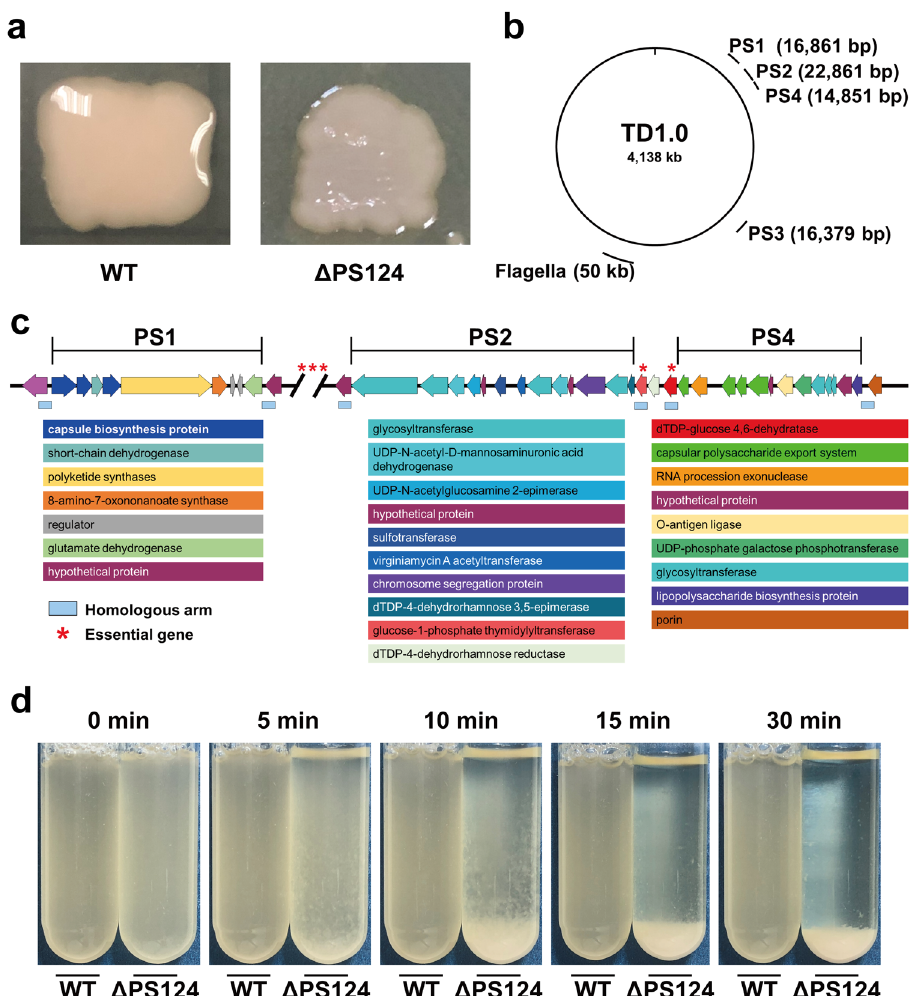
Fig. 2 Deletion of EPSs synthesis pathway in H. bluephagenesis . a Morphology of wild type and Δ PS124 cultured on LB60 agar plate. b The relative position of PS1, PS2, PS3, and PS4 and fl agellar gene cluster in the genome of H. bluephagenesis . c The deleted EPSs clusters in Δ PS124. d Self- fl occulation of Δ PS124 and TD1.0 after standing for 0 – 30 min. The strains were cultured in LB60 medium for 24 h and used for self- fl occulation test. WT, H . bluephagenesis TD1.0; Δ PS124, H . bluephagenesis TD1.0 with deletion of PS1, PS2, and PS4 gene clusters; PS1, PS2, PS3, and PS4, the gene clusters involved in exopolysaccharide synthesis; Flagella, the gene cluster for fl agella